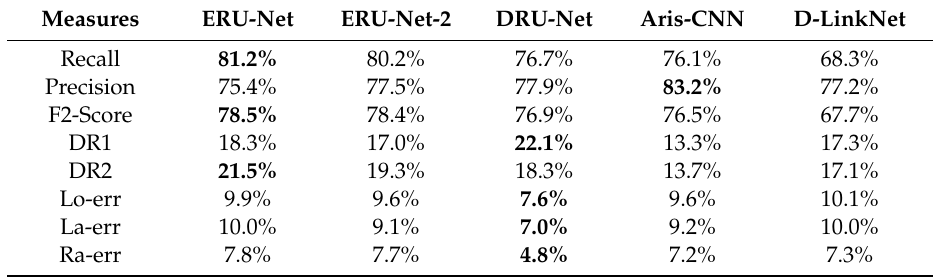
Table 1. The recognition results of different network models on 30,000 training images (bold in the table means the best results on this evaluation index).